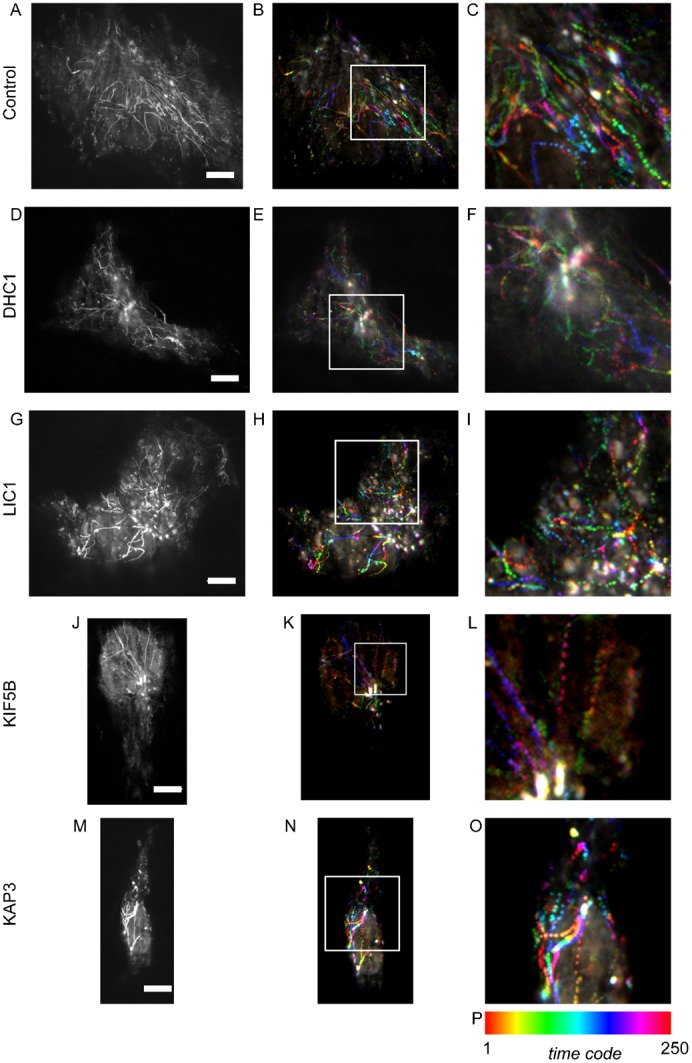
Projections of time lapse sequence from TIRF imaging of tsO45-G-GFP translocation.Image sequences comprise 1000 frames acquired at 12.04 frames per second. (A,D,G,J,M) Maximum intensity projections generated from all 1000 frames. B,E,H,K,N (enlarged in panels C,F,I,L,O) Colour coded time projections of every fourth frame from these sequences (332 ms intervals, 250 frames total). (P) The colour coding for time projections. Scale bars: 10 µm (A–O).